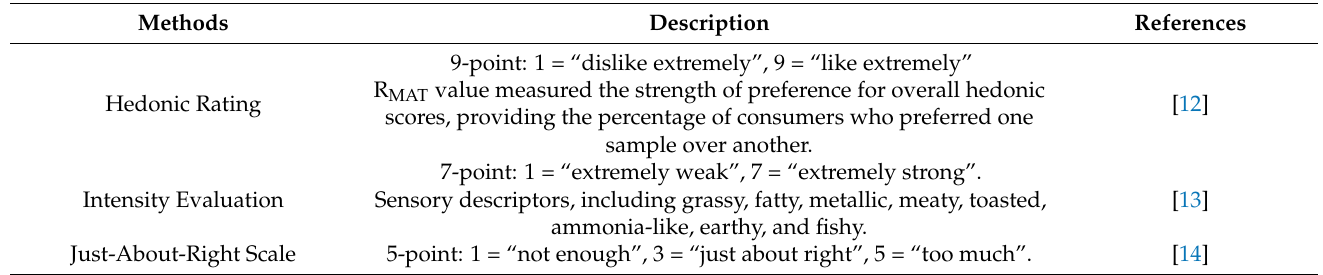
Table 2. Sensory evaluation process and description of E. sinensis